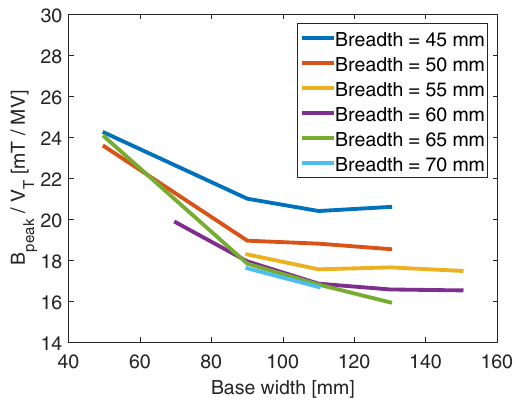
=V FIG. 7. B T vs tip width for different values of tip breadth. peak The base width and breadth were fixed at 110 mm and 65 mm,